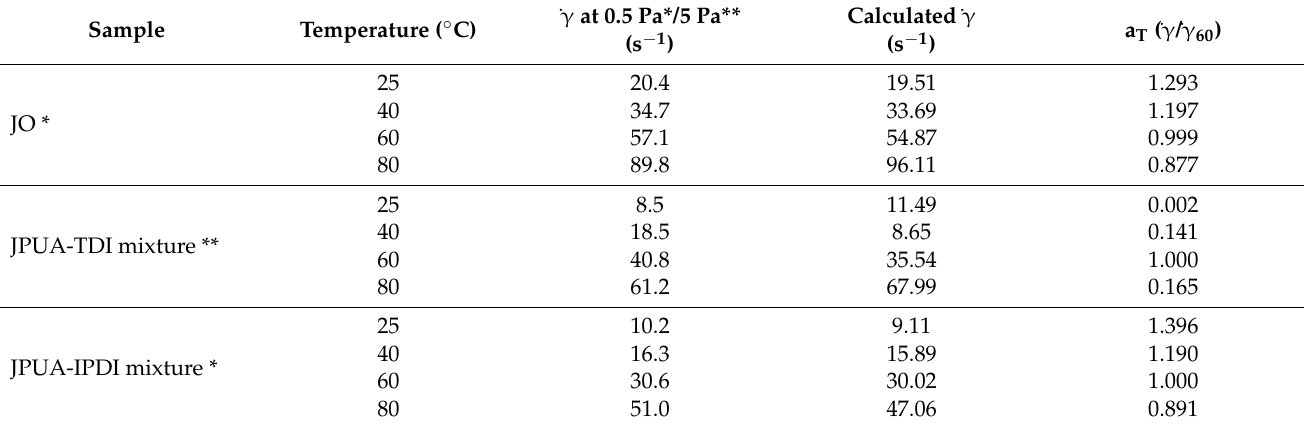
Table 5. Shear rates and shift factor values with reference to calculated˙ γ at 60 ◦